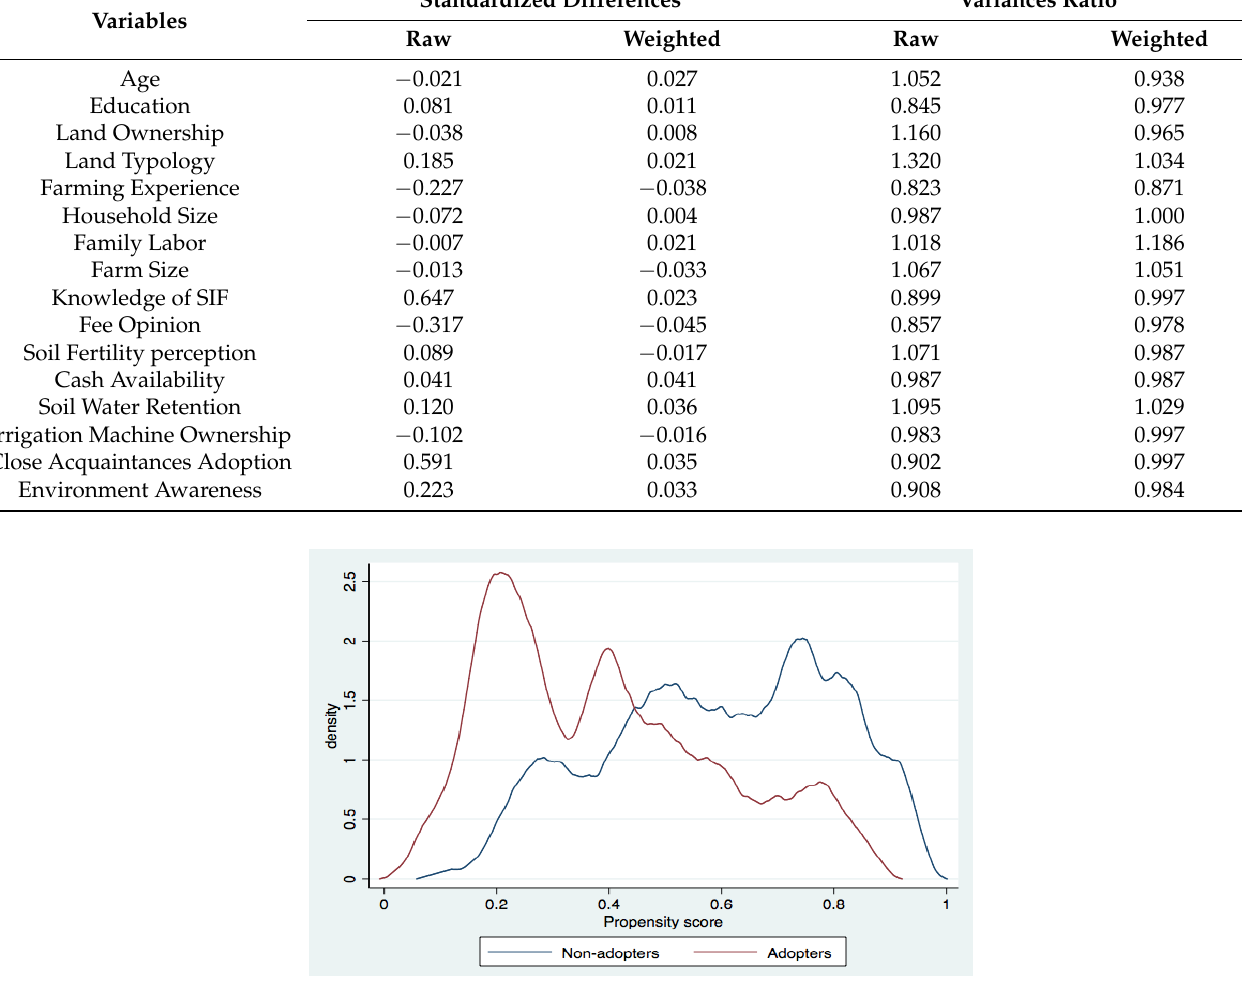
Figure 2. Test of overlap assumption. Table 5. Average treatment effects of solar irrigation adoption on outcome